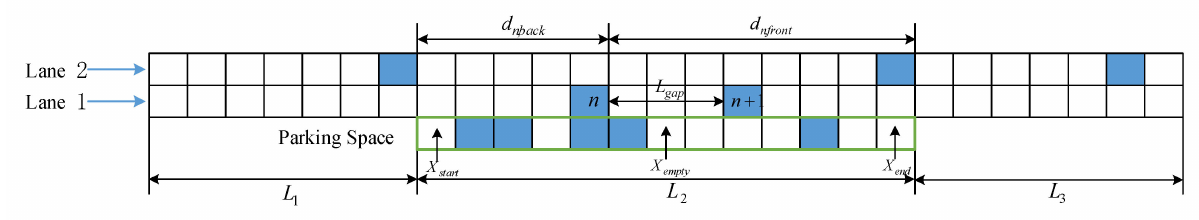
Figure 2. Simulation model based on the cellular automata model for on-street cruising for